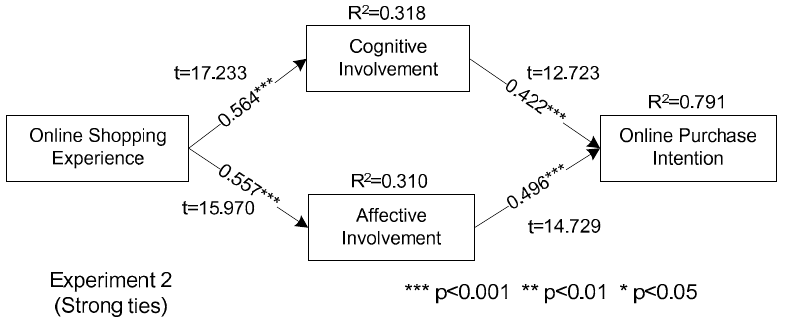
Figure 3. Results of structure model analysis (strong ties).